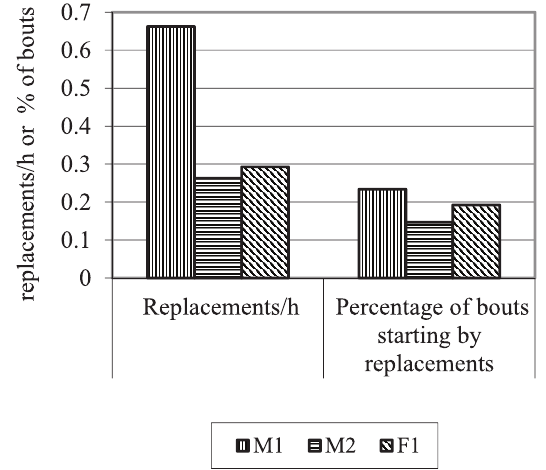
Figure 5. a . Number of replacements/h and b . percentage of guarding bouts that started by replacing an active sentinel.